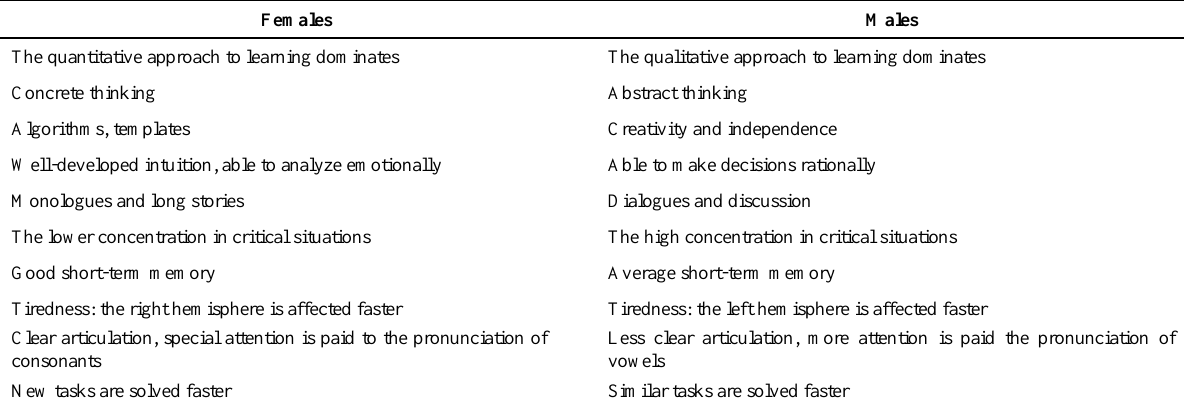
Table 2. Gender learning